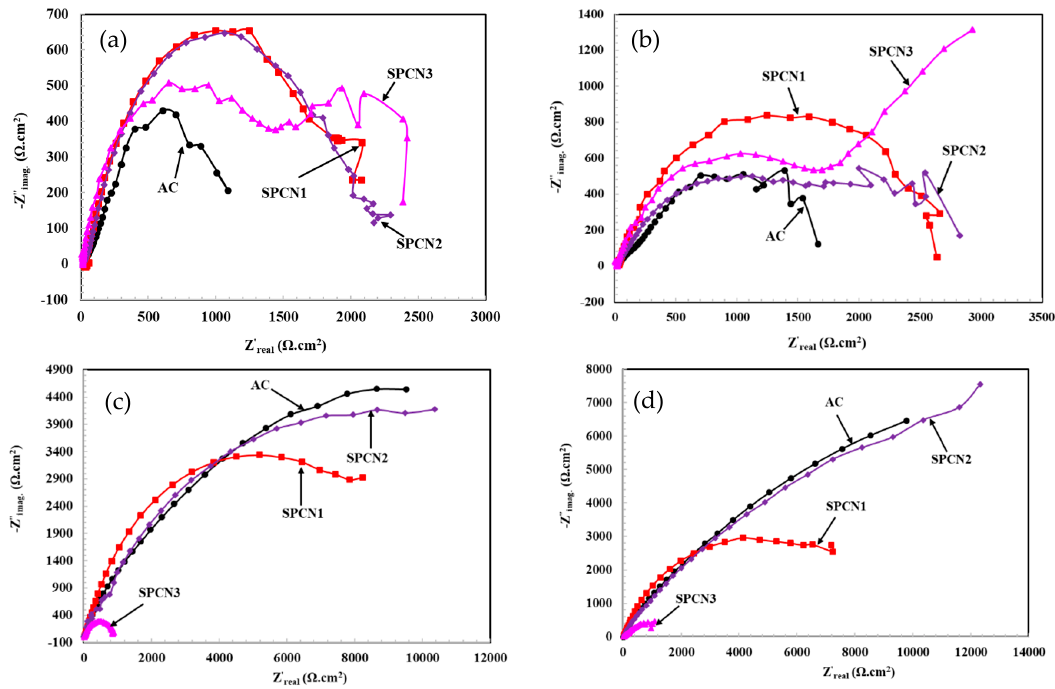
Figure 4. Complex-plane impedance plots of coatings after ( a ) 1 h, ( b ) 11 days, ( c ) 41 days, and ( d ) 89 days of exposure in 3.5 wt.% NaCl solution.